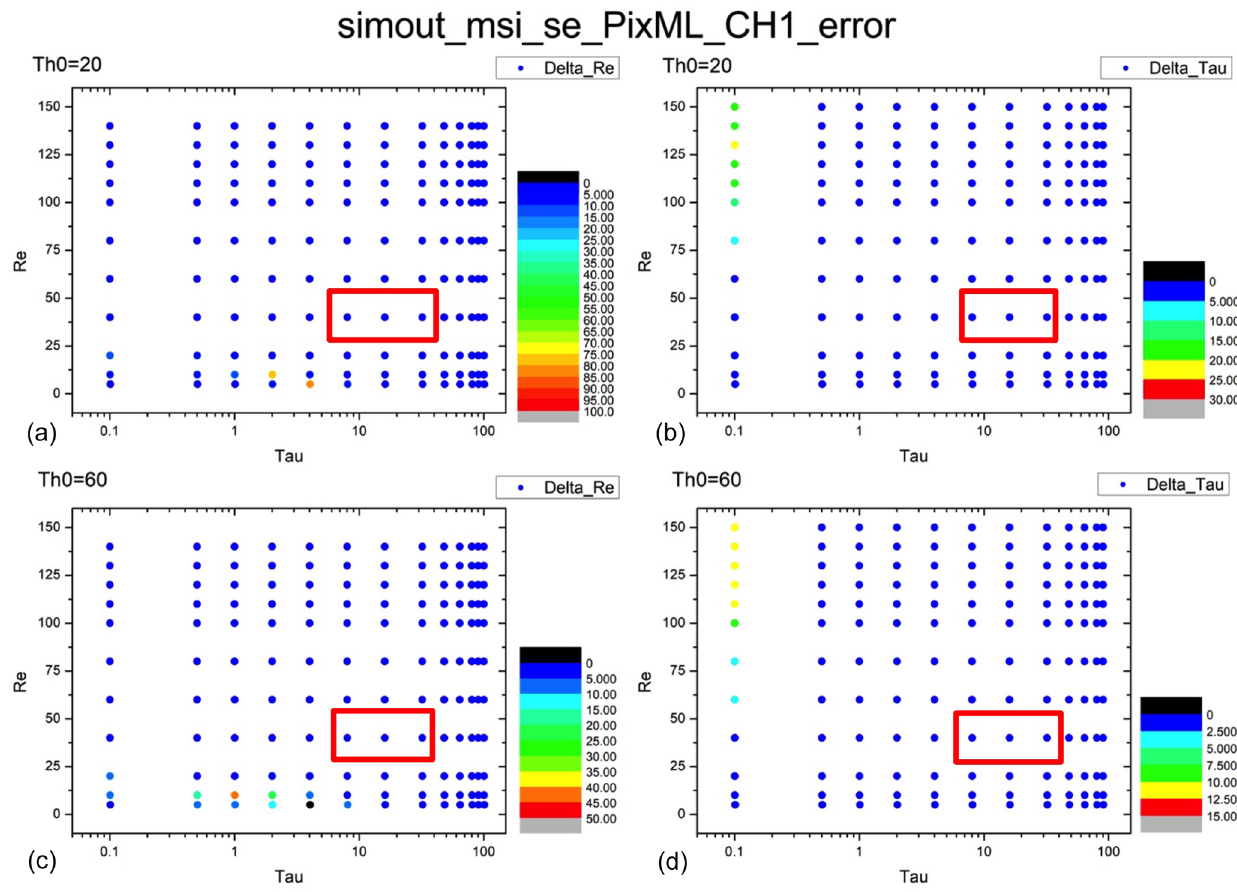
Figure 12. Error distributions of COT and CDR from the Nakajima–King diagram for deep convective clouds at pix_BND1_max. (a) Distri- bution of (cid:49)r e for a solar zenith angle of 20 ◦ . (b) Distribution of (cid:49)τ for a solar zenith angle of 20 ◦ . (c) Distribution of (cid:49)r e for a solar zenith angle of 60 ◦ . (d) Distribution of (cid:49)τ for a solar zenith angle of 60 ◦ . The red frames show the presence of typical deep convective clouds. COT = 8 or 32, CDR =